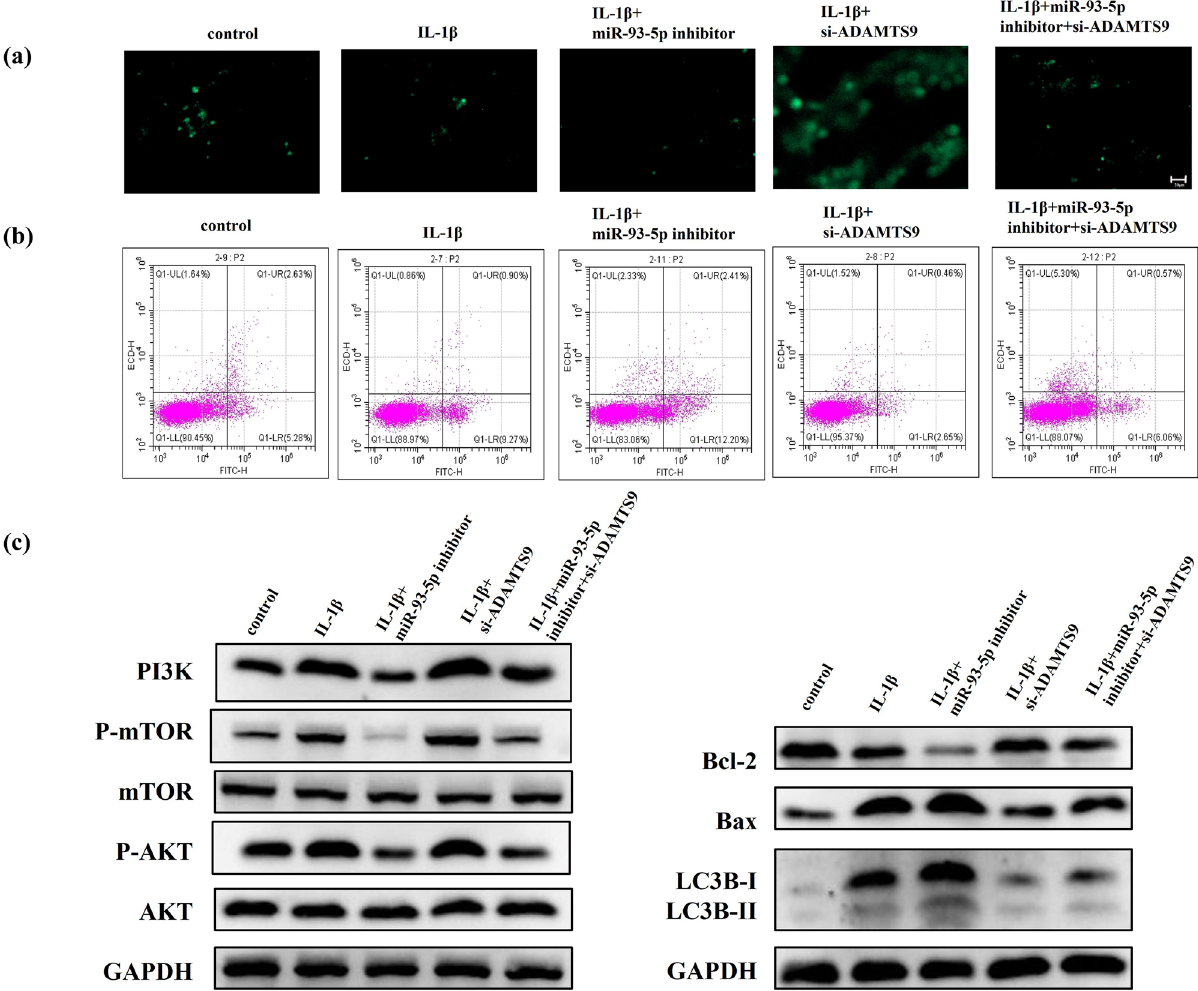
Figure 3: miR - 93 - 5p inhibited autophagy and apoptosis of IL - 1 β - treated chondrocytes by targeting ADAMTS9 to activate the PI3K/AKT/mTOR pathway. Note: ( a ) MDC staining was used to detect the autophagy of control, IL - 1 β , IL - 1 β + miR - 93 - 5p inhibitor, IL - 1 β + si - ADAMTS9, and IL - 1 β + miR - 93 - 5p inhibitor + si - ADAMTS9 group in chondrocytes. ( b ) Flow cytometry was used to detect the apoptosis of control, IL - 1 β , IL - 1 β + miR - 93 - 5p inhibitor, IL - 1 β + si - ADAMTS9, and IL - 1 β + miR - 93 - 5p inhibitor + si - ADAMTS9 group in chondrocytes. ( c ) Western blot assay was used to detect the expression of PI3K, P - mTOR, P - AKT, Bcl - 2/Bax, and LC3B - I/II expression of control, IL - 1 β , IL - 1 β + miR - 93 - 5p inhibitor, IL - 1 β + si - ADAMTS9, and IL - 1 β + miR - 93 - 5p inhibitor + si - ADAMTS9